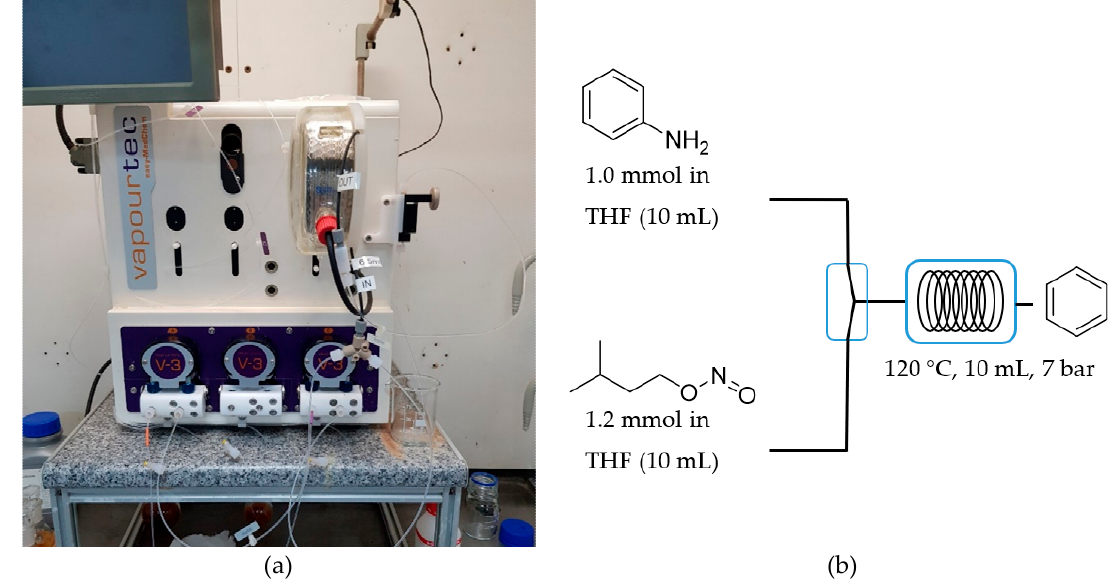
Figure 1. ( a ) The Vapourtech EasyMedChem system used to perform the experiments. ( b ) A diagram to show the general procedure of heterocyclic amine